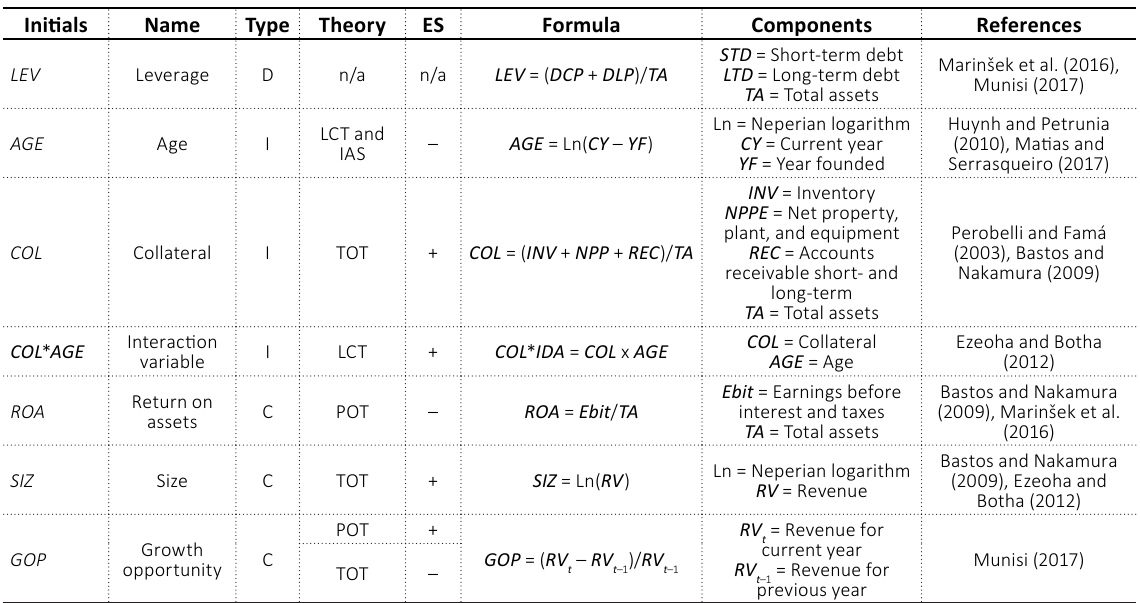
Table 1. Econometric model